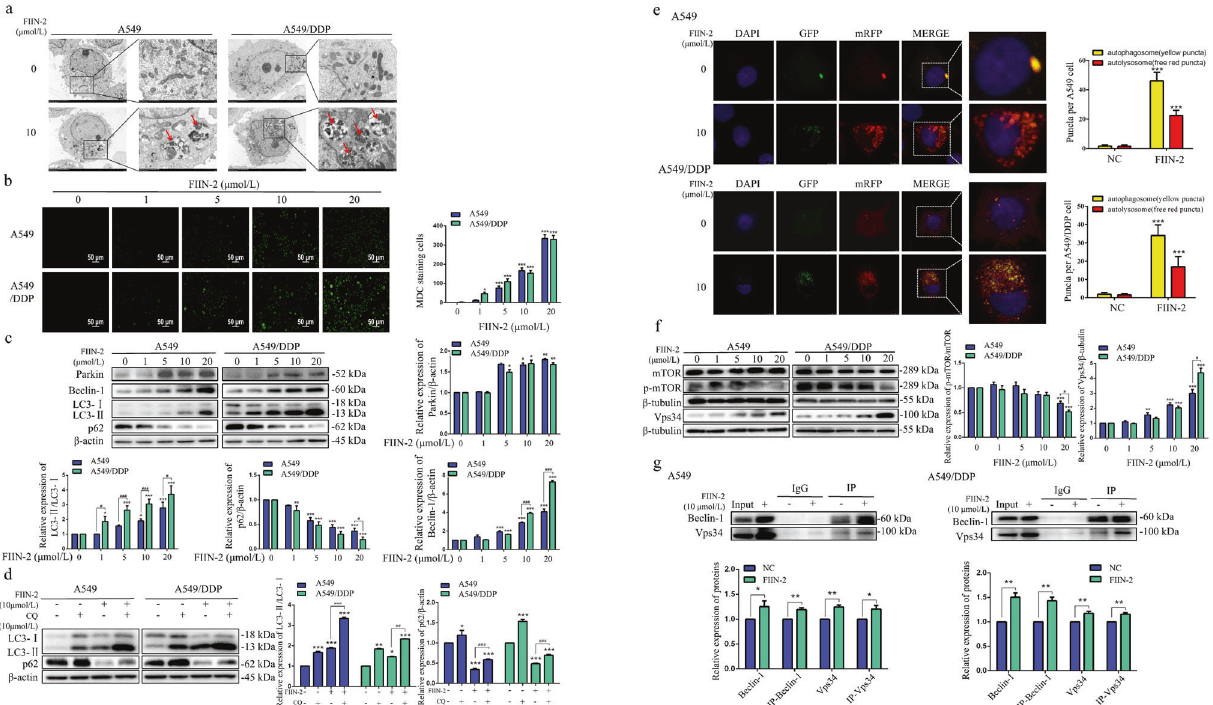
Fig. 4 FIIN-2 induced autophagic fl ux in A549 and A549/DDP cells through mTOR inhibition and the activation of the class III PI3K pathway. a A549 and A549/DDP cells were treated with 10 μ mol/L FIIN-2 for 24 h, and the autophagy characteristics were observed by transmission electron microscopy (TEM). b The MDC assay was used to observe the induction of autophagy by FIIN-2 (0 – 20 μ mol/L) in A549 and A549/DDP cells. c Cells were treated with FIIN-2 (0 – 20 μ mol/L) for 24 h, and the levels of Parkin, Beclin-1, p62, and LC3 were detected by western blot analysis. d A549 and A549/DDP cells were cotreated with 10 μ mol/L CQ and 10 μ mol/L FIIN-2 for 24 h, then the levels of LC3-II/ LC3-I and p62 were detected by western blot. e After the mRFP-GFP-LC3 lentiviral vector was transfected into A549 and A549/DDP cells, the effect of FIIN-2 (10 μ mol/L) on autophagic fl ux was evaluated (yellow dots: autophagosomes; red dots: autophagolysosomes). f Cells were treated with FIIN-2 (0 – 20 μ mol/L) for 24 h, and the levels of p-mTOR and Vps34 were detected by western blot analysis. g The effect of FIIN-2 (10 μ mol/L) on the Vps34-Beclin-1 complex was analysed by immunoprecipitation. β -actin and β -tubulin were used as the loading controls. Each bar corresponds to the mean ± SD of three independent experiments. * p < 0.05, ** p < 0.01, *** p < 0.001; # p < 0.05, ## p < 0.01, ### p <